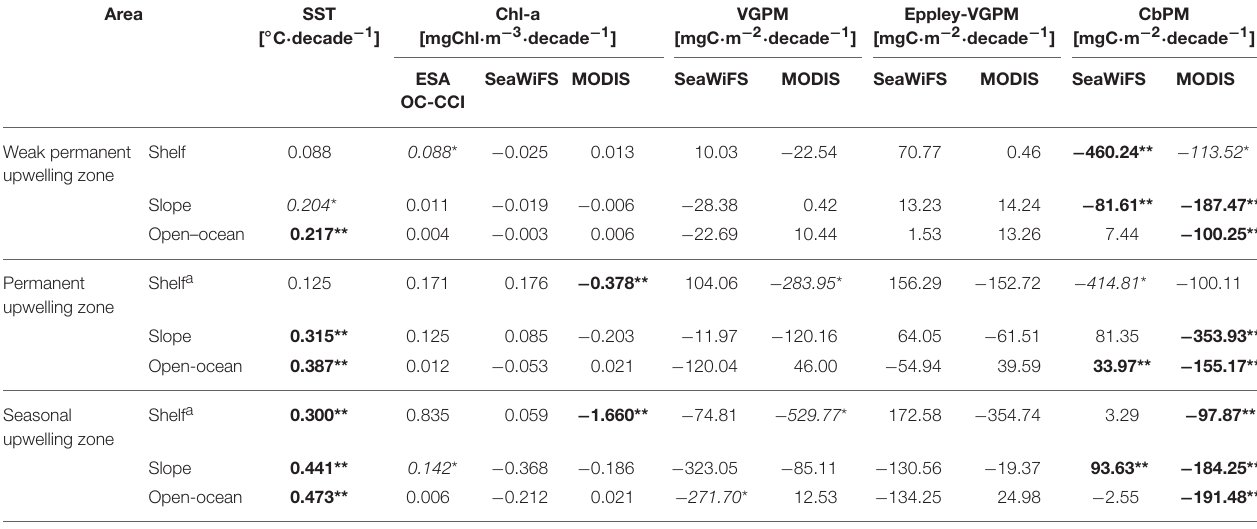
TABLE 1 | Average trends for SST (1993–2014), Chl-a and NPP (VGPM, Eppley-VGPM, and CbPM), for 1998–2007 (SeaWiFS) and 2003–2015 (MODIS) periods in each of the upwelling subregions over the shelf (0–200m), continental slope (200–2,000m) and open-ocean region ( > 2,000m, as far as 28 ◦ W).